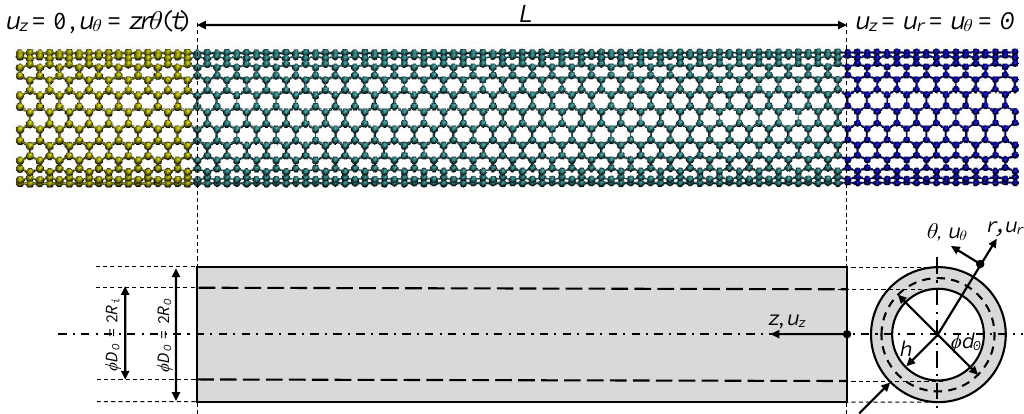
Figure 1. Schematic illustration of SWCNT and its equivalent continuum model boundary conditions for torsional